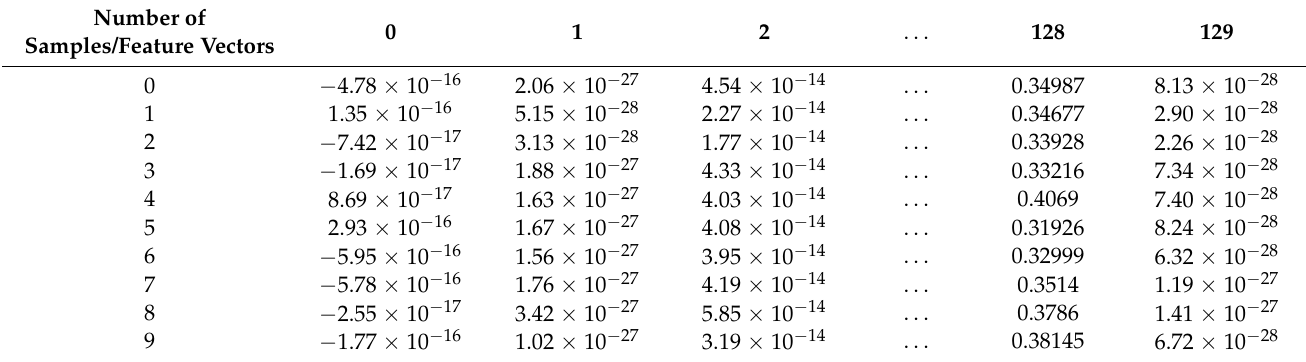
Table 1. Representation of feature